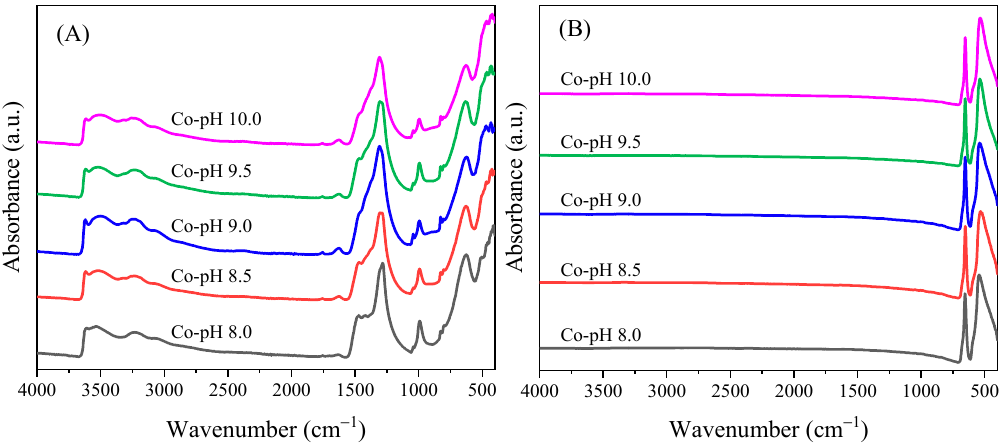
Figure 2. Fourier transform-infrared spectroscopy (FTIR) spectra of ( A ) cobalt precursors and ( B ) cobalt oxides prepared at di ff erent pH